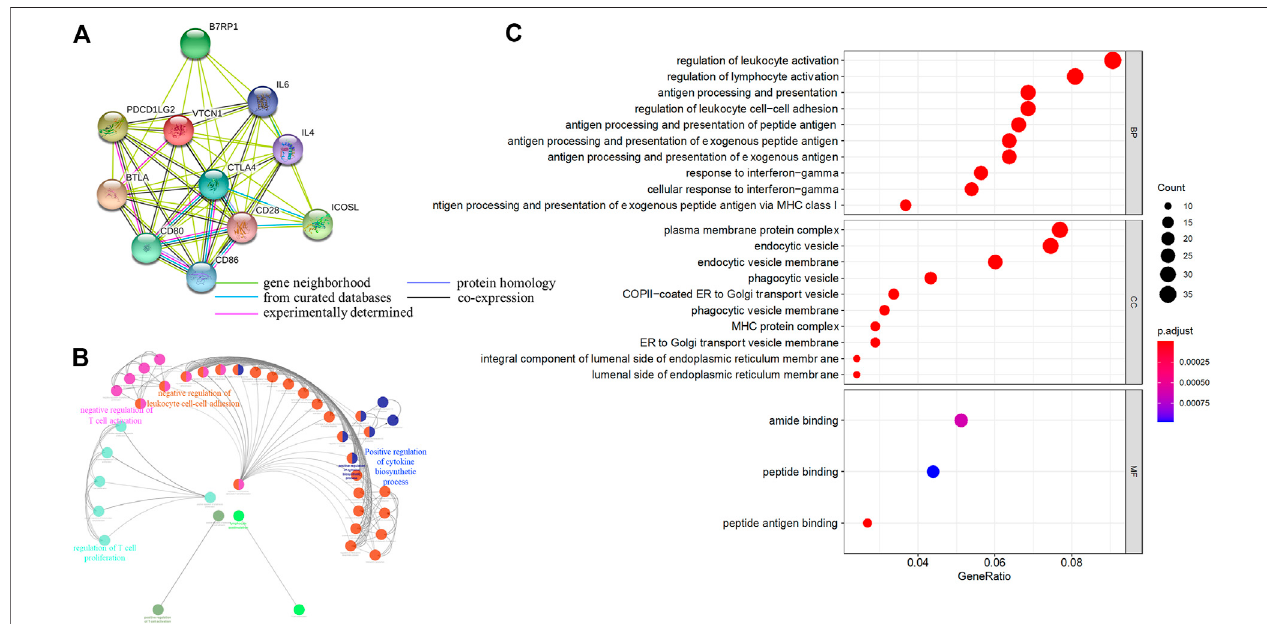
FIGURE4 | Functional annotations and predicted signaling pathway of VTCN1 in OvCa. (A) The PPI network of VTCN1 constructed using STRING. (B) Functional annotation of the VTCN1 -related module genes constructed by ClueGo. (C) Signi fi cantly enriched GO annotations of VTCN1 in OvCa. BP: biological processes. CC: cellular components; MF: molecular